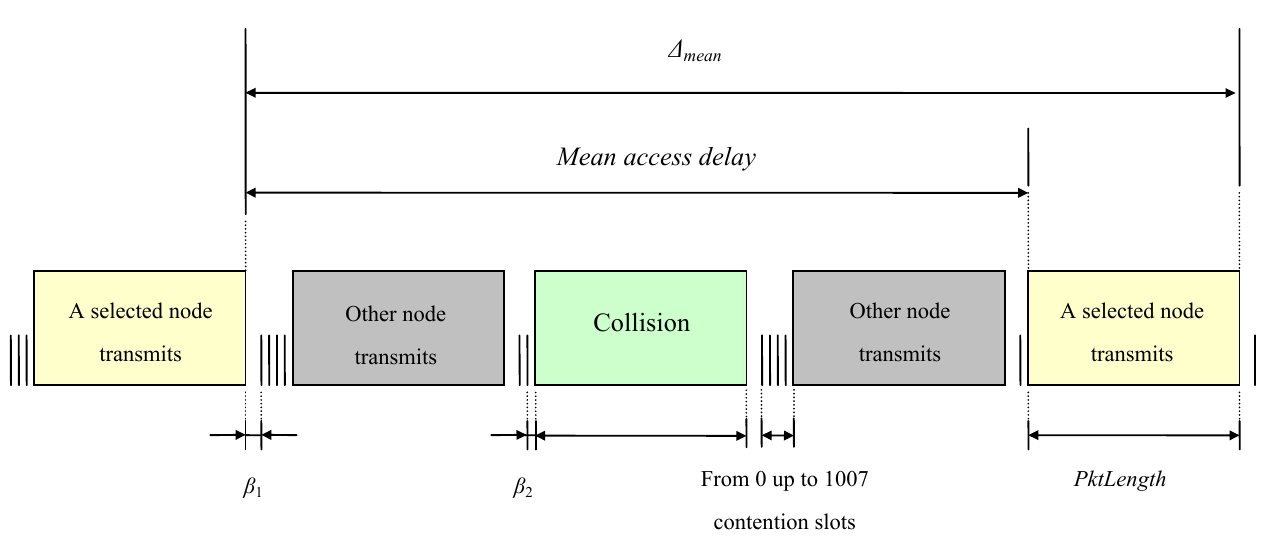
Figure 2 . A packet access delay